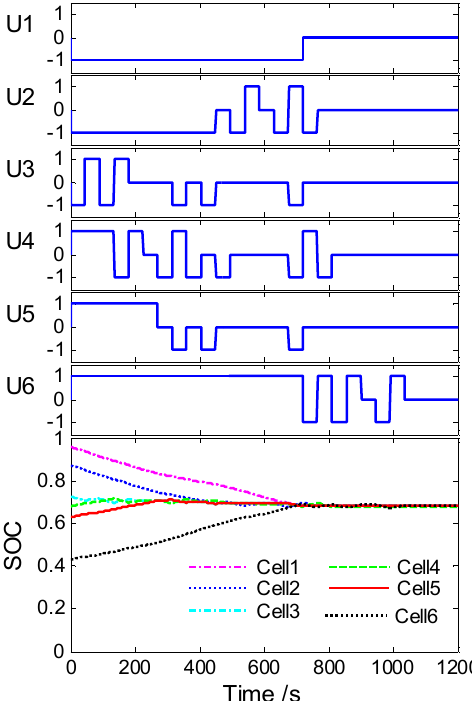
Figure 22. Based on the general control.